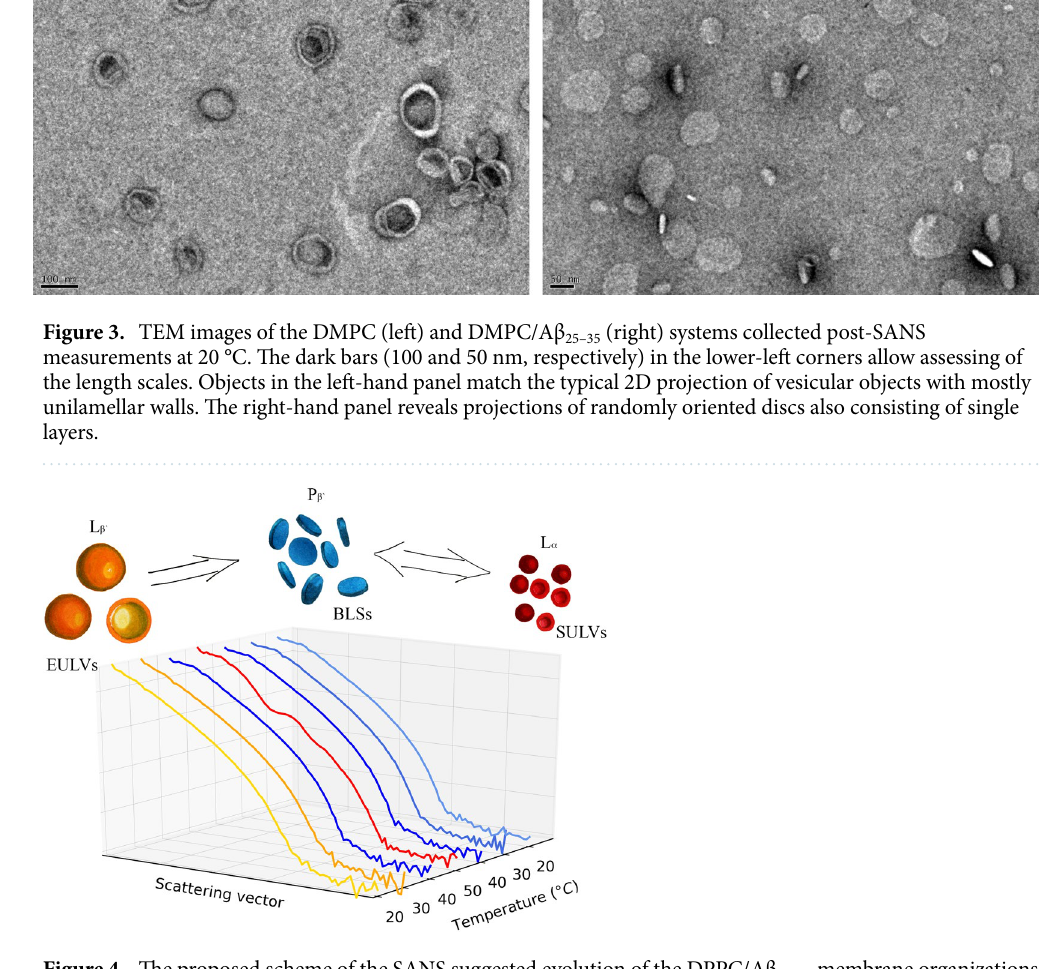
Figure 4. The proposed scheme of the SANS suggested evolution of the DPPC/Aβ 25–35 membrane organizations during the temperature changes. The SANS curves are colored corresponding to their best fit models shown above. The transition from the initial EULVs to BLSs is irreversible, while the BLSs transition to SULVs